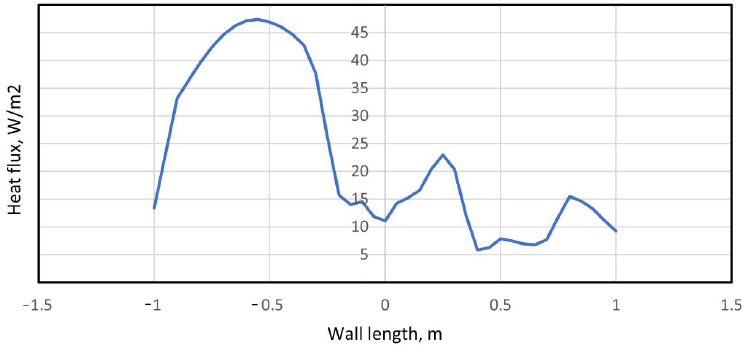
Figure 11. Heat flux q on the top wall.